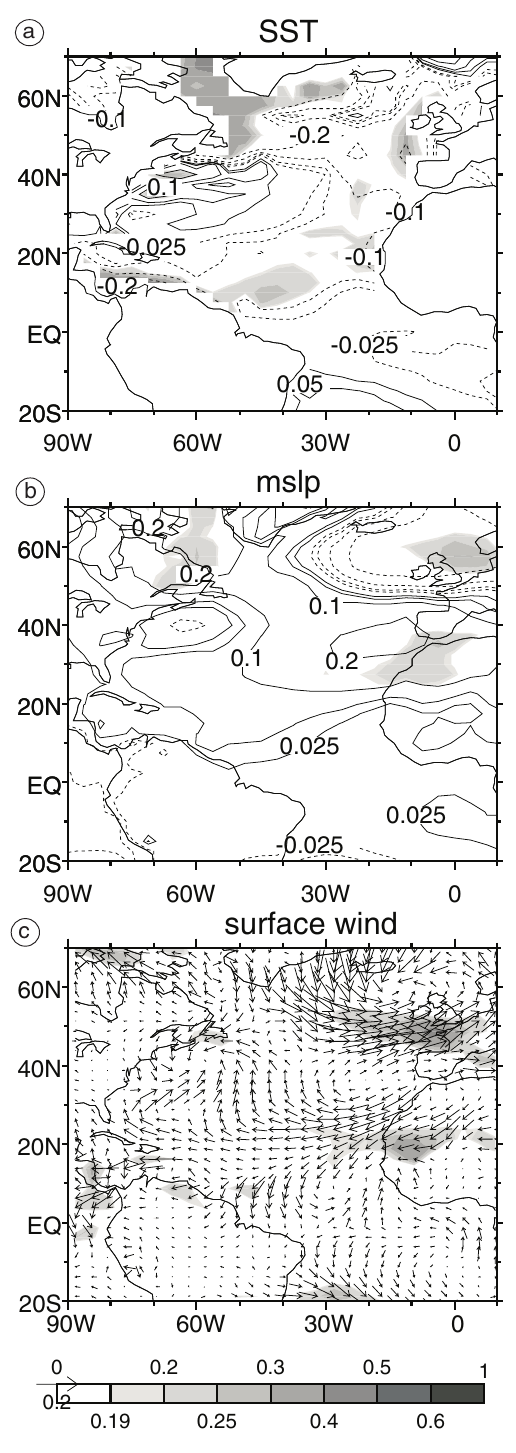
Fig. 4a-c. The regression patterns of low frequency annual sea surface temperature (a), mean sea level pressure (b), and surface wind (c) to the PC2 of the MOC when MOC leading by 4 years for the HadCM3 simulation. Units are in o C, hPa, and m s –1 per unit PC2 of the MOC. Shading scale indicates explained local